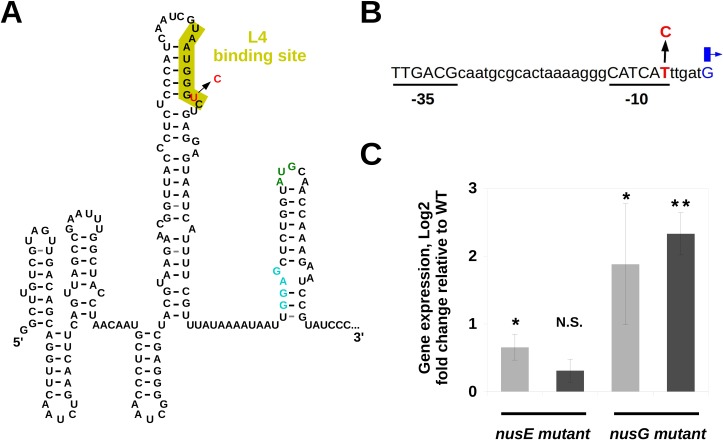
Location and effects of the mutations in the regulatory regions of nusE and nusG.(A) Structure of the leader transcript of the nusE operon as determined in [50]. The ribosome binding site and the translation start codon are shown in light blue and green, respectively. The mutated nucleotide (red) is located in a region (marked in yellow) essential for the attenuation mediated by L4 [45,47,51]. (B) Sequence of the promoter region of the secE-nusG transcript. The transcription start site is indicated by the blue arrow. The mutation (red) affects the −10 sequence [44]. (C) Log2 fold change of the expression of nusE (light grey) and nusG (dark grey) genes in each mutant with respect to the wild type, measured by quantitative real-time PCR (RT-qPCR) (from left to right, mean ± twice the standard error of the mean [2SEM], p-values of one sample t-test are: 0.65 ± 0.19, p = 0.020; 0.31 ± 0.17, p = 0.068; 1.88 ± 0.89, p = 0.052; 2.33 ± 0.31, p = 0.004; n = 3).